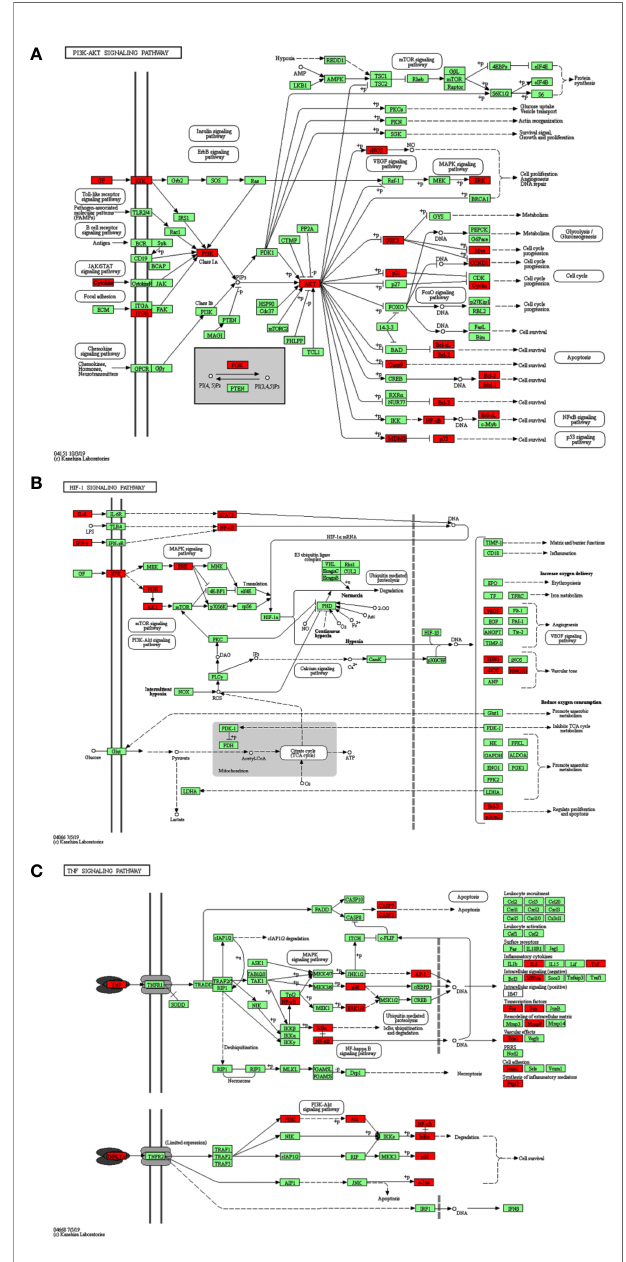
FIGURE 7 | KEGG signaling pathway. (A) PI3K-AKT signaling pathway, (B) HIF-1 signaling pathway, (C) TNF signaling pathway.